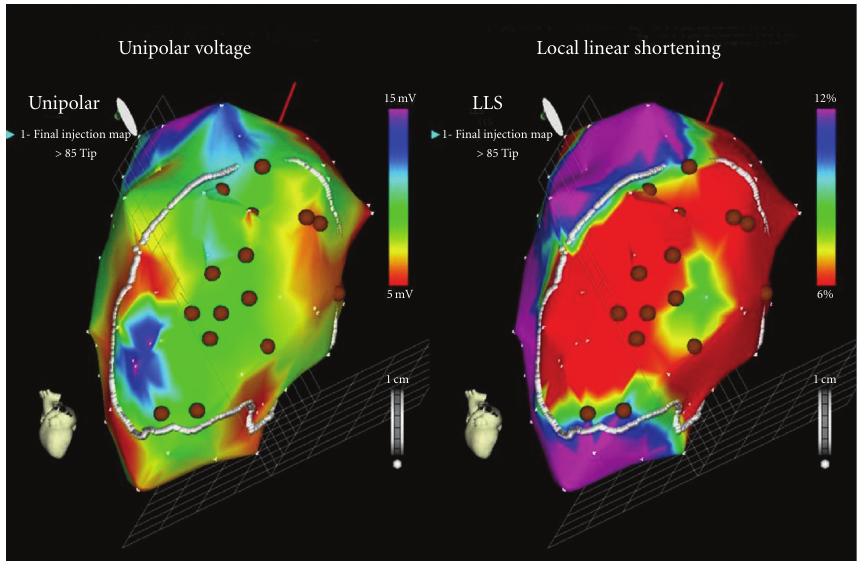
Figure 2: Electromechanical mapping of the left ventricle with the NOGA XP System (BDS, Cordis Corporation, Johnson and Johnson) from a patient enrolled in the PRECISE trial in our centre. Myocardial areas with low contractility and impaired endocardial voltage are identified as viable and targeted for cell injection